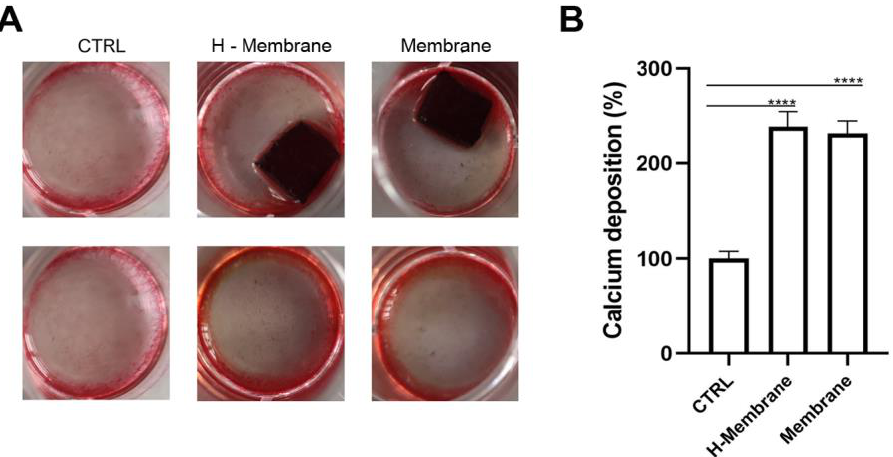
Figure 8. Alizarin red staining on osteoblasts cultured for 14 days ( A ), calcium deposition quantification at 14 days ( B ), (**** p < 0.0001).